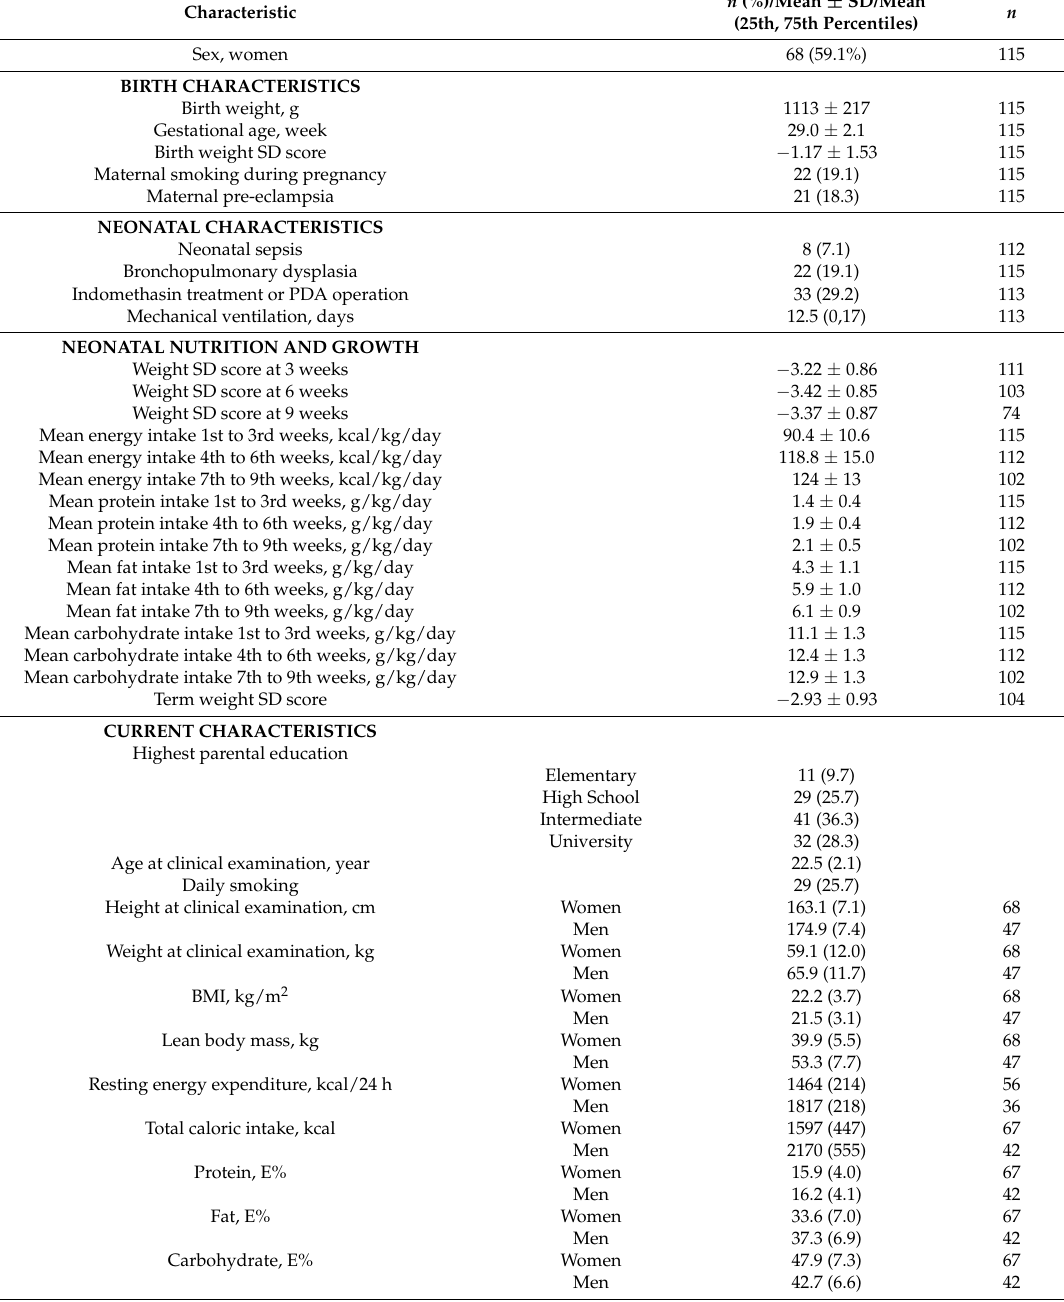
Table 1. Characteristics of the study